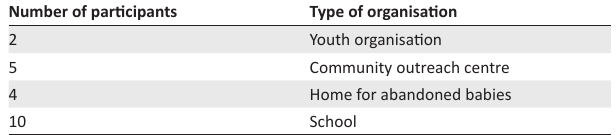
TABLE 2: Types of organisations where participants